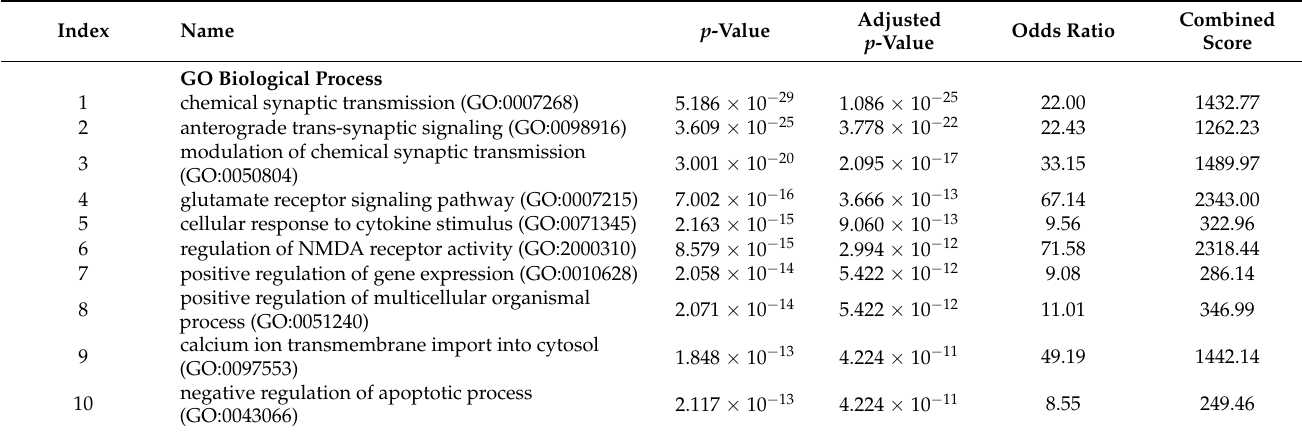
Table 2. Overall results of enrichment analysis using